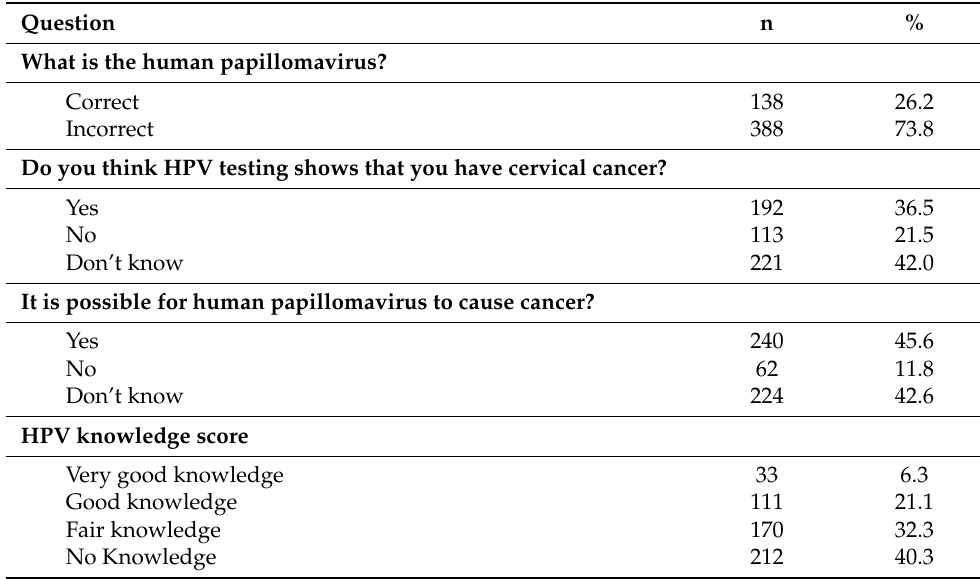
Table 2. Knowledge of